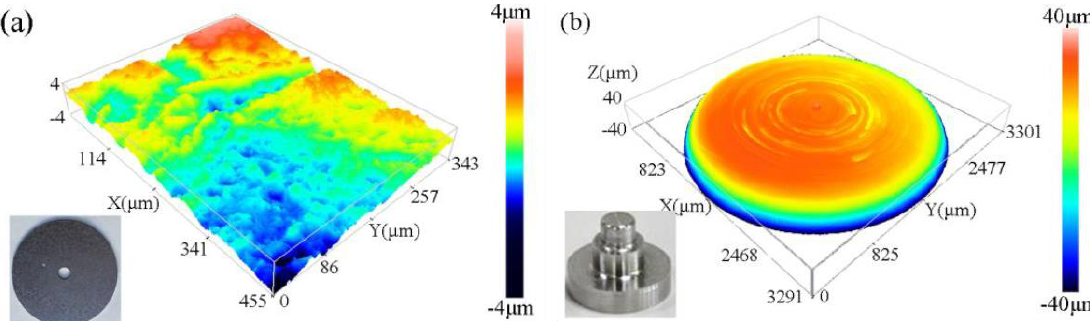
Figure 1. As-delivered conditions: ( a ) Surface topography of the blank and ( b ) surface topography of the tool.